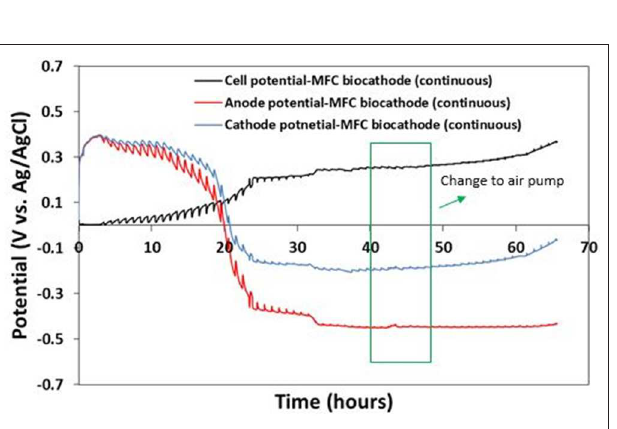
FIGURE 6 | Cell, anode, and cathode potentials of MFC equipped with GDE and IOB biocathode and operated in fed-batch mode.